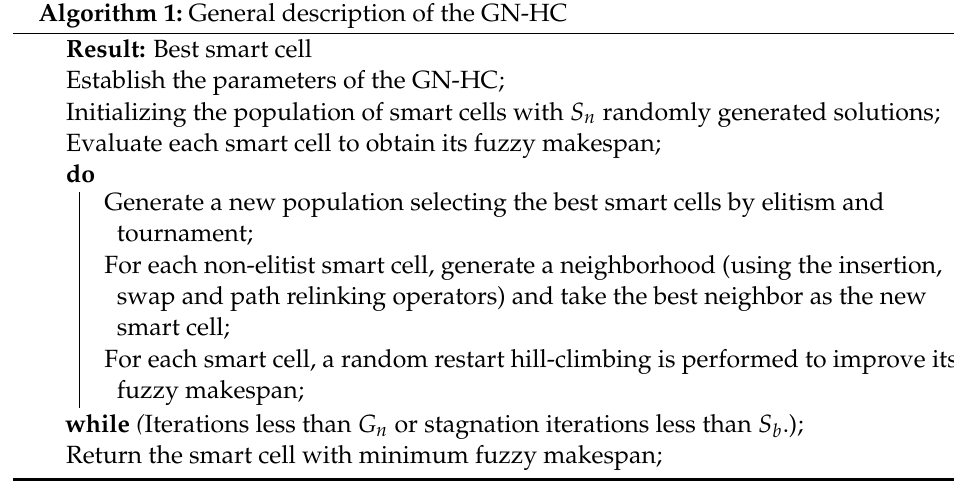
Algorithm 1: General description of the